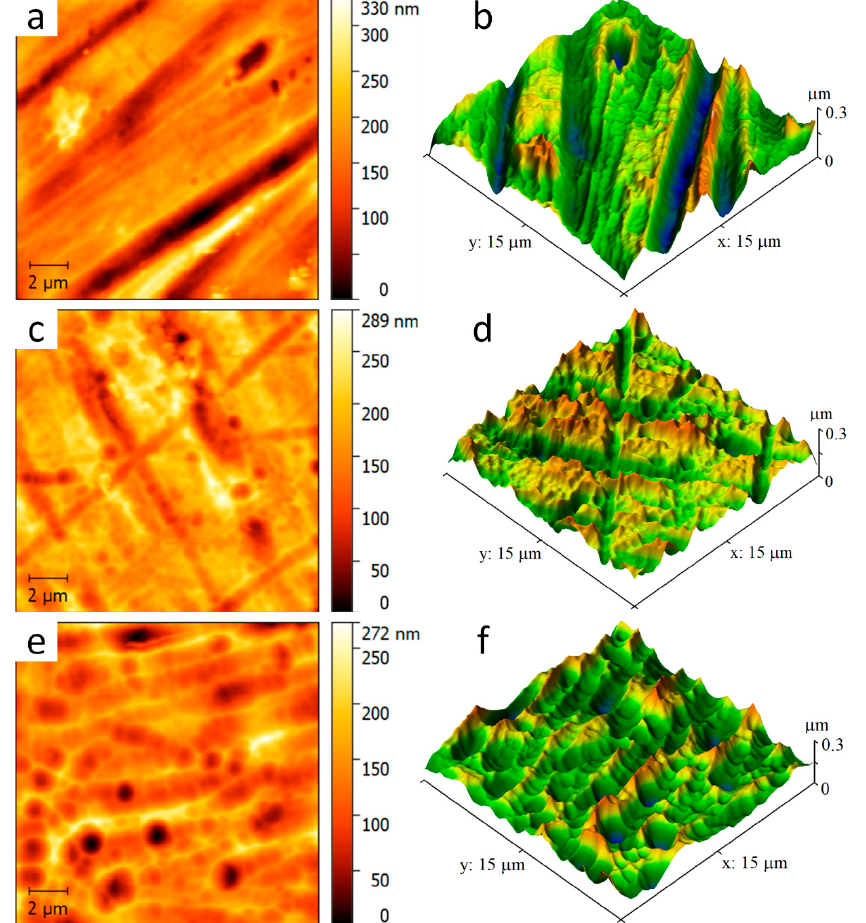
Figure 4. Two- and three-dimensional SPM images of Ti-6Al-4V alloy surface with a-C:H:SiO x film of different thickness before in vitro biodegradation in 0.9% NaCl solution: ( a , b ) 0.5 µ m, ( c , d ) 1.5 µ m, ( e , f ) 3 µ m. Table 2. Roughness values for Ti-6Al-4V alloy surface with a-C:H:SiO x film of different thickness before in vitro biodegradation in 0.9% NaCl solution, X ± SD. Thickness, µm R max , nm R mean , nm R a , nm R q , nm Uncoted Ti-6Al-4V 352 ± 22 164 ± 14 45 ± 5 56 ± 7 0.5 ± 0.1 330 ±